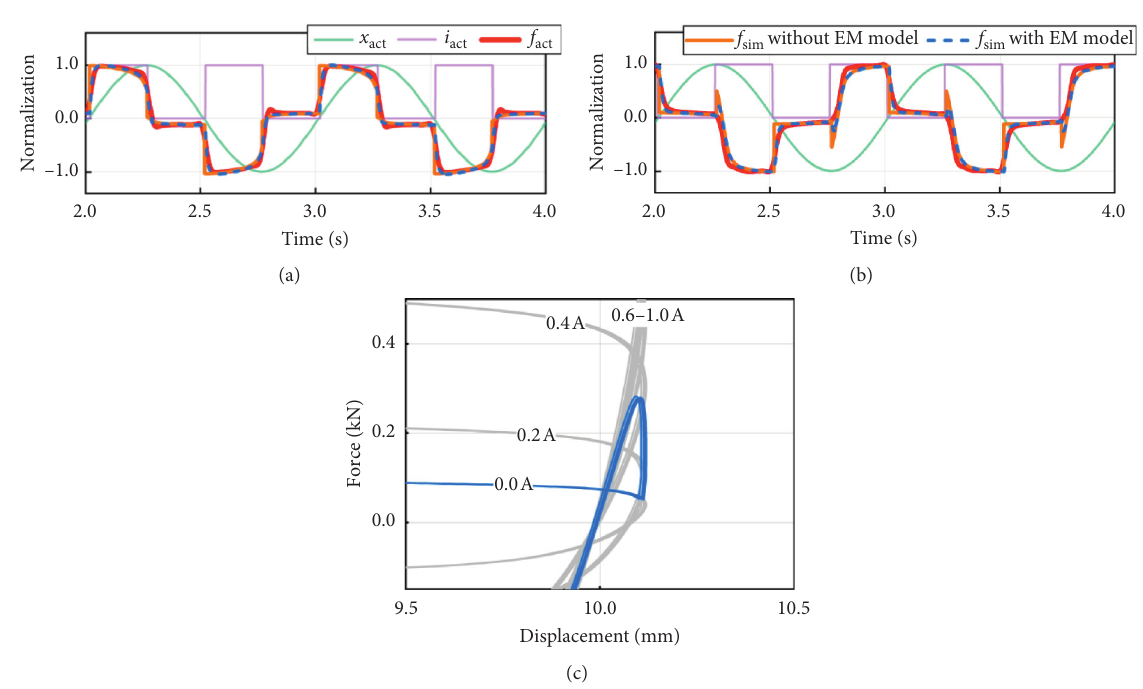
Figure 5: Electromagnetic phenomenon for step current input. (a) Case A. (b) Case B. (c) Force versus displacement for Case B.